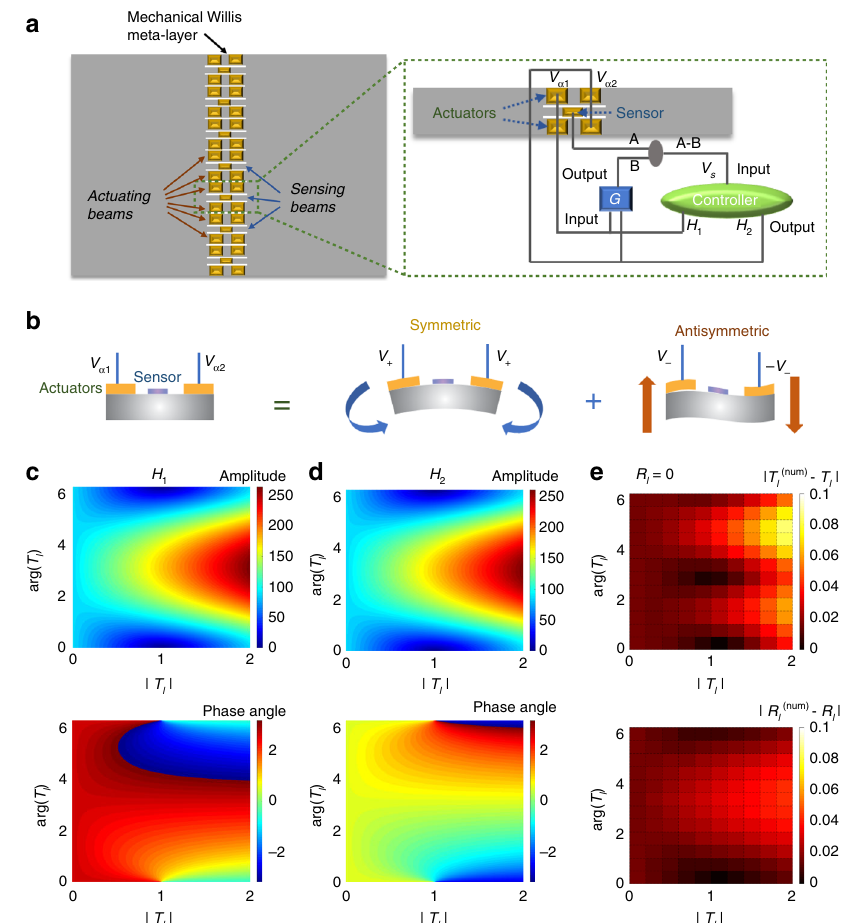
Fig. 2 Design and working principles of the Willis meta-layer. a Microstructural design of the active Willis meta-layer. Geometric and material parameters of the design are given in Supplementary Fig. 4 and Supplementary Table 2. b Working principles of the active meta-layer. c , d Designed amplitudes and phases of electrical transfer functions, ( c ) H 1 and ( d ) H 2 of a transmission-type meta-layer ( R l = 0) with the amplitude of the transmission coef fi cient, T l varied from 0 to 2 (horizontal axis) and with a full 2 π phase change coverage (vertical axis). Source data are provided as a Source Data fi le. e Differences between numerically calculated transmission and re fl ection coef fi cients and their prescribed values to be achieved with the corresponding transfer functions in ( c ) and ( d ). Source data are provided as a Source Data fi